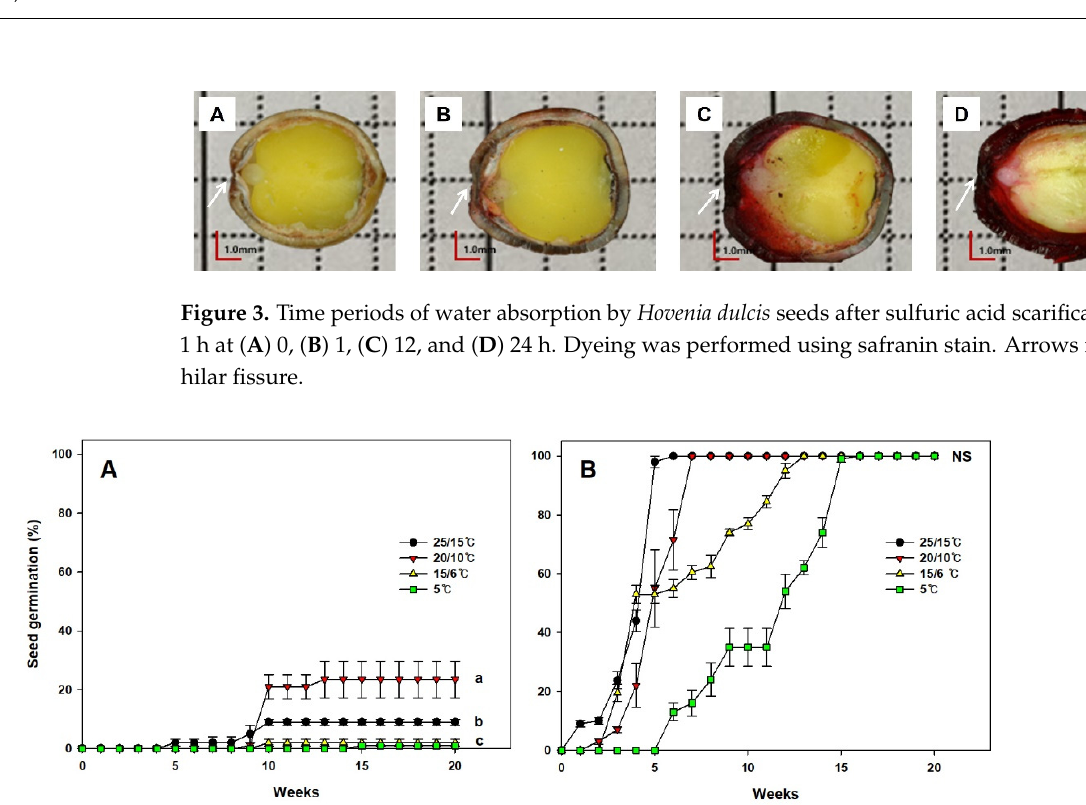
Figure 4. Germination of Hovenia dulcis seeds at various temperature regimes after ( A ) no treatment and ( B ) 98% sulfuric acid scarification for 1 h. Vertical bars show ± SE of four replicates. The different letters represent statistically significant differences for germination percentages according to treatments in the 20th week as determined by Duncan’s multiple range test ( p < 0.05).